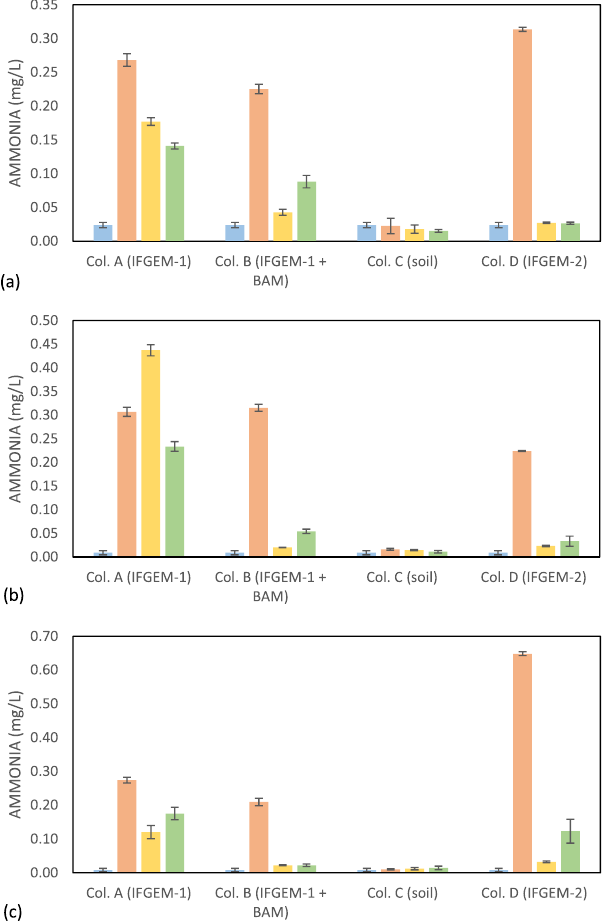
Figure 6. Outcome of the column study: ammonia concentrations at the outlet of each section through columns when inlet nitrate concentration = ( a ) 0.6 mg/L, ( b ) 1.2 mg/L, and ( c ) 1.8